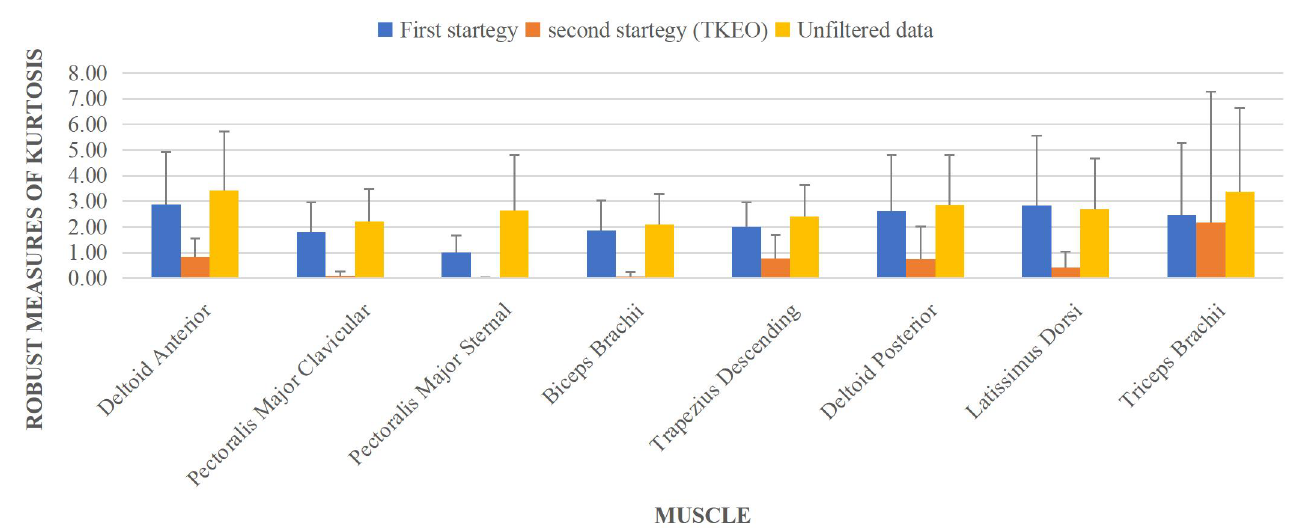
Figure 5. Estimated muscle onset based on different strategies.